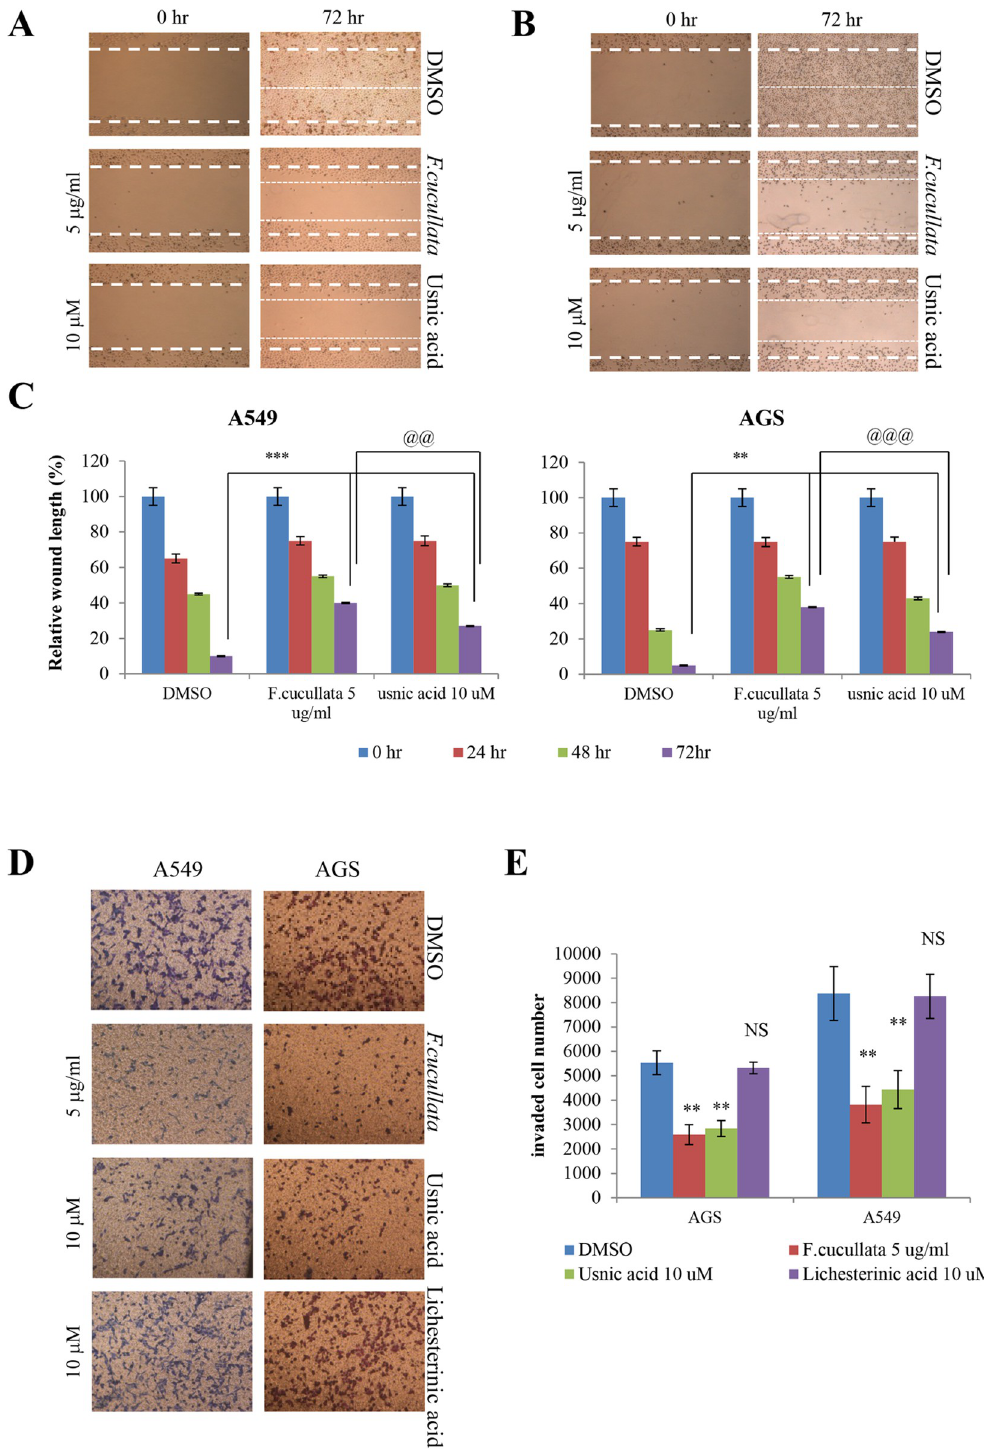
Fig 6. Inhibition of the motility of A549 and AGS cancer cells by the acetone extract of F . cucullata and usnic acid in sub-lethal concentrations. (A–C) Migration assay of A549 (A) and AGS (B) cells treated with the F . cucullata extract or usnic acid, and quantificational analysis of wound length in each group (C). (D–E) Invasion assay of A549 and AGS cells treated with the F . cucullata extract, usnic acid, or lichesterinic acid (D), and quantificational analysis of invaded cell numbers in each group (E). Representative images are shown from three independent experiments. Data represent